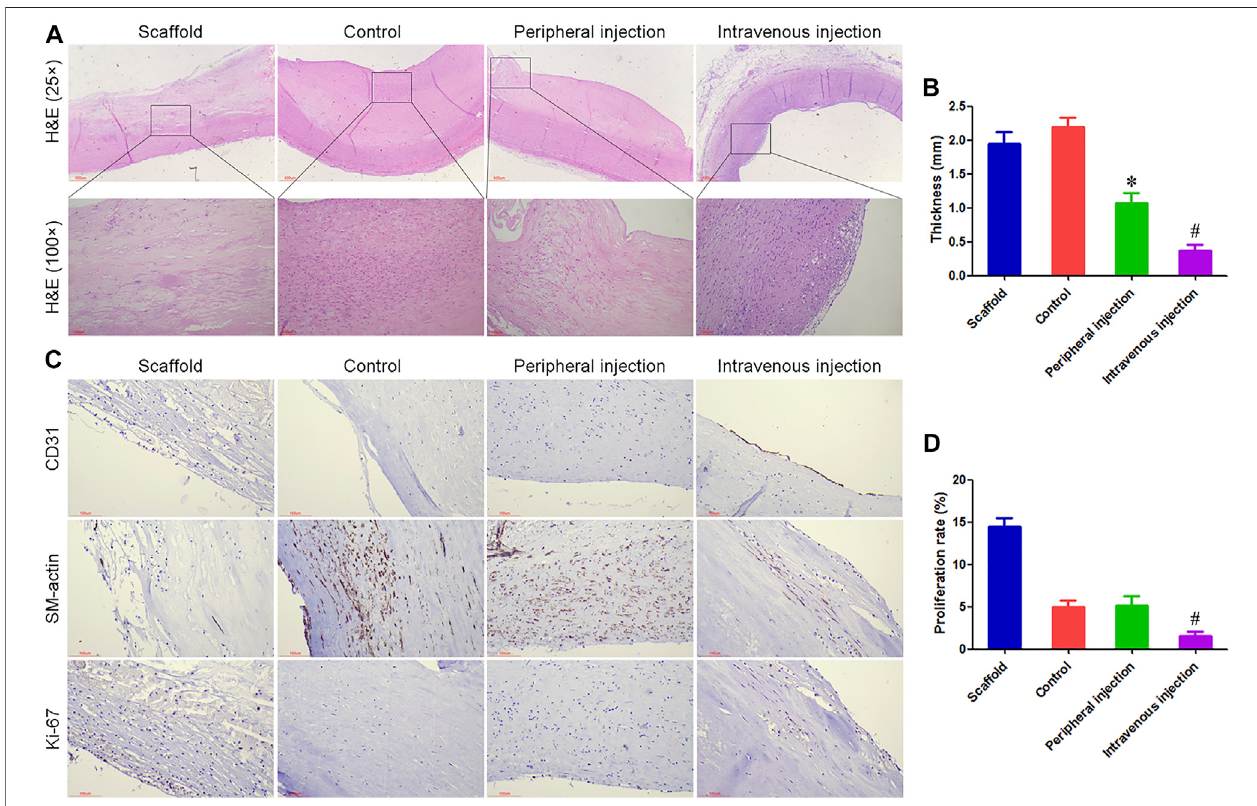
FIGURE2| Tregcell transplantation inhibited intimal hyperplasia ofanti-CD34antibody modi fi ed TEBV indiabetes mellitus. (A) Hand Estaining, allTEBV were not completelyblockedat60 daysafterimplantation. (B) Thethicknessofintimalhyperplasiaintheintravenousinjectiongroupwassmallerthanthatinthecontrolgroupand peripheral injection group. (C) Immunohistochemistry was used to detect the expression of CD31, SM-actin, and ki-67. An intact endothelial cell layer was observed in the intravenous injection group. (D) Ki-67 proliferation index in the intravenous injection group was smaller than that in the control group and peripheral injection group. * p < 0.05 ( n = 8) versus Control group. # p < 0.05 ( n = 8) versus Peripheral injection group. Values are mean ±